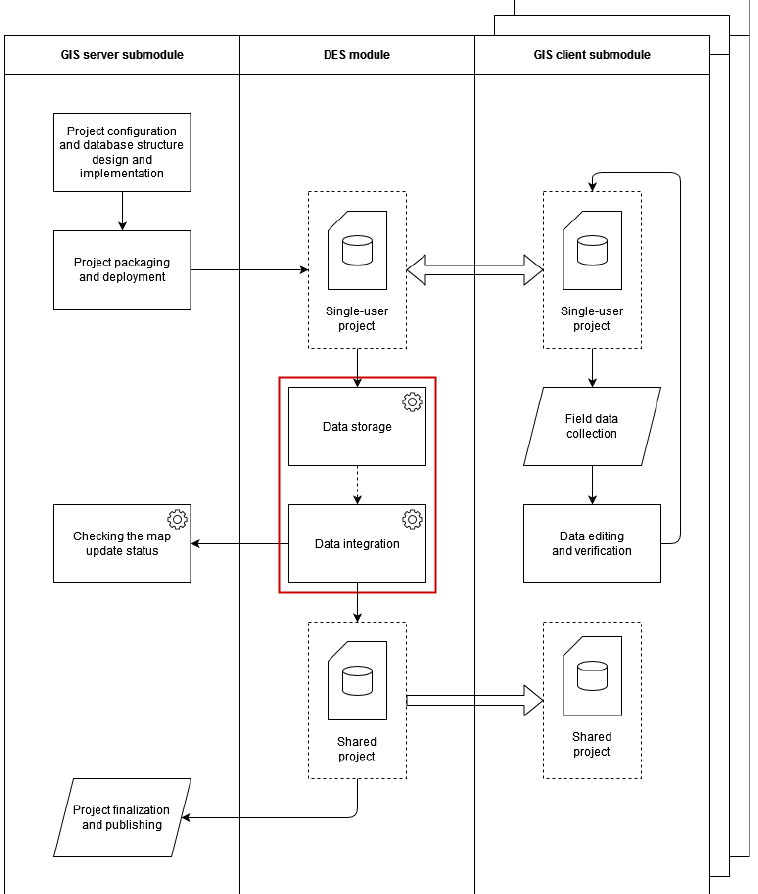
Figure 1. Conceptual scheme of the IT infrastructure: GIS server submodule, DES module and GIS client submodule. The “gears” point out the operations that are performed automatically, the large arrows indicate the synchronization process, and the red box highlights the designed algorithm, which is further detailed in Figure